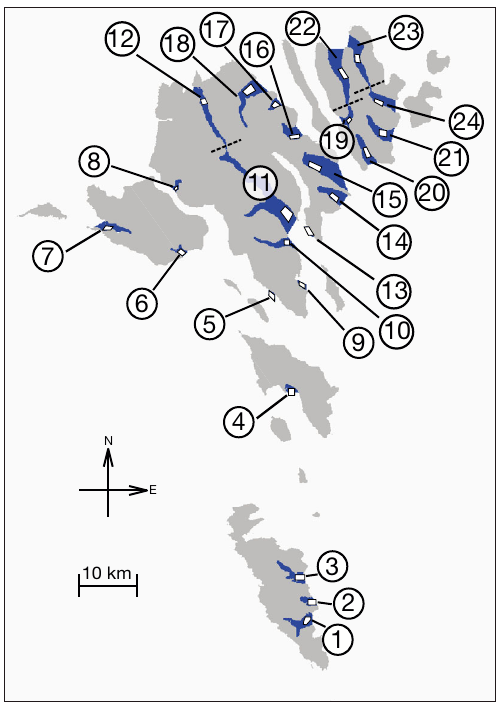
Fig. 3. Farm areas (blue) and lice release sites (white poly- gons). Dashed lines distinguish 2 farm areas from each other. There is water connection between Farm areas 11 and 12, but not between 19 and 22, and 23 and